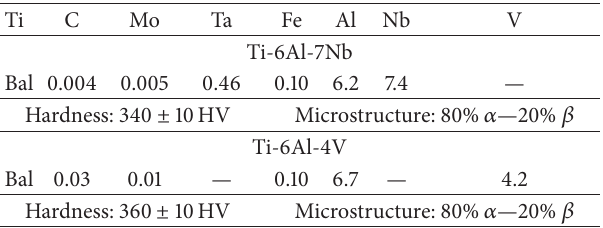
Figure 1: Scheme of plane contact (pin-on-disc): (1) speed regulator, (2) support, (3) rotating tray, (4) load applied, (5) sample, (6) retaining frame; friction pairs used: Ti-6Al-4V and Ti-6Al-7Nb sliding against number 320 abrasive paper; sliding distance: 1400 m. Table1:Chemicalcomposition,hardness,andmicrostructureofthe metallic materials